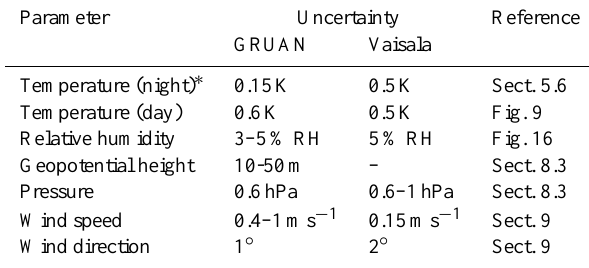
Table 8. Summary of the uncertainty estimates for RS92 data for GRUAN processing (second column) and for Vaisala processing according to Vaisala (2007) (third column). The estimates for the vertically resolved GRUAN uncertainties on temperature and hu- midity are given for 25–30km altitude. The GRUAN uncertainty on pressure is given for the switch altitude. The estimates for wind speed and direction are 1 σ statistical uncertainties. The right-most column lists the relevant sections/figures of this